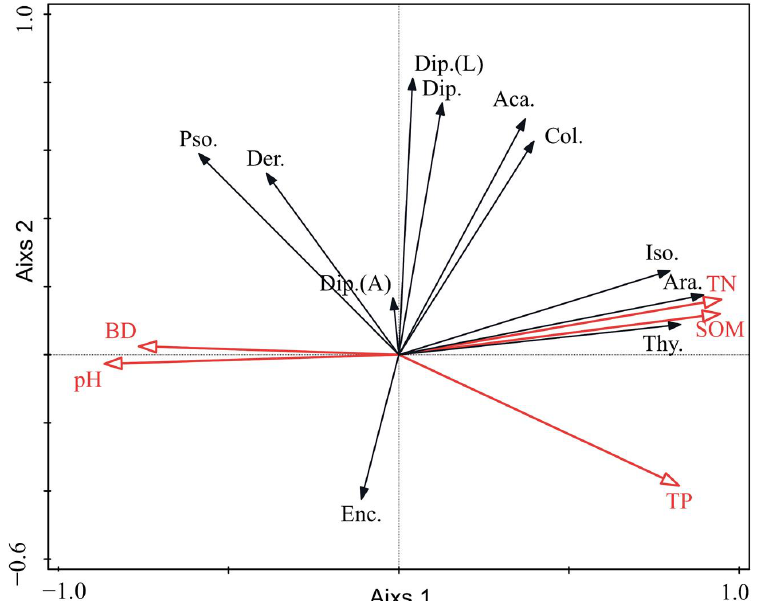
Figure 5. Redundancy analysis between main groups of the soil fauna and the selected properties of soil. Red arrows represent soil properties labeled as: soil bulk density (BD), soil pH value (pH), soil organic matter (SOM), total nitrogen (TN), and total phosphorus (TP). Black arrows represent groups of soil fauna labeled as: Acarina ( Aca. ), Araneae ( Ara. ), Collembola ( Col. ), Dermaptera ( Der.